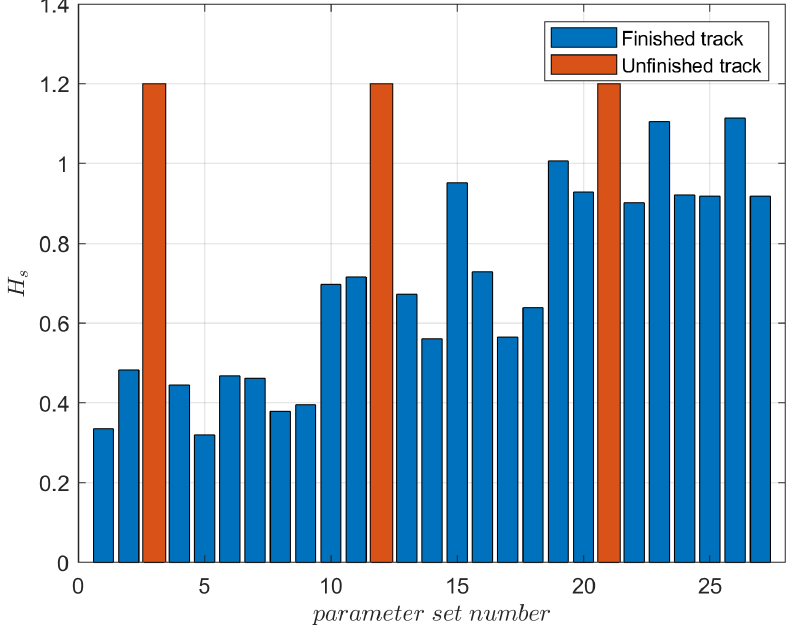
Figure 5. Path matching accuracy for the specified parameter set number—track